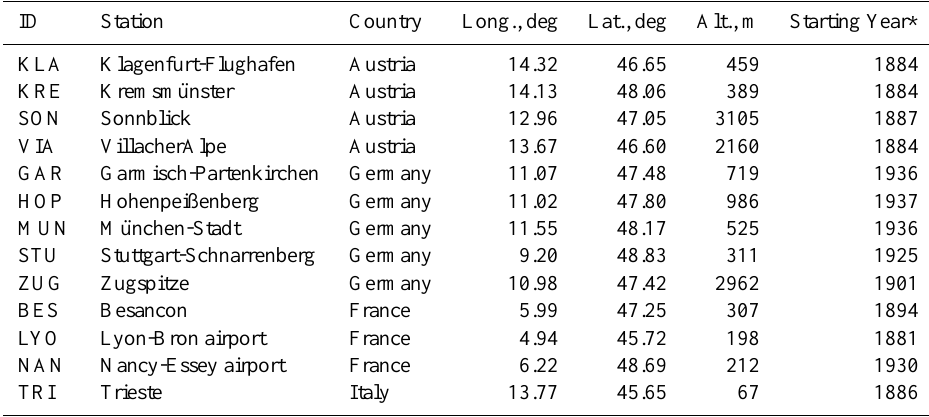
a Indication of composite series ( Y es/ N o) and the year of the station’s change. b Davos, Luzen, Montana, Neuchatel and Scuol measurements of TCC are only available until 2005, 2007, 1996, 2006 and 2005, respectively. * Stations considered homogeneous for clear-sky SD series. Table 2. Details of the 13 longest SD series in the HISTALP data set used to support the homogeneization of the records in Switzerland, including the starting year of the measurements (source: